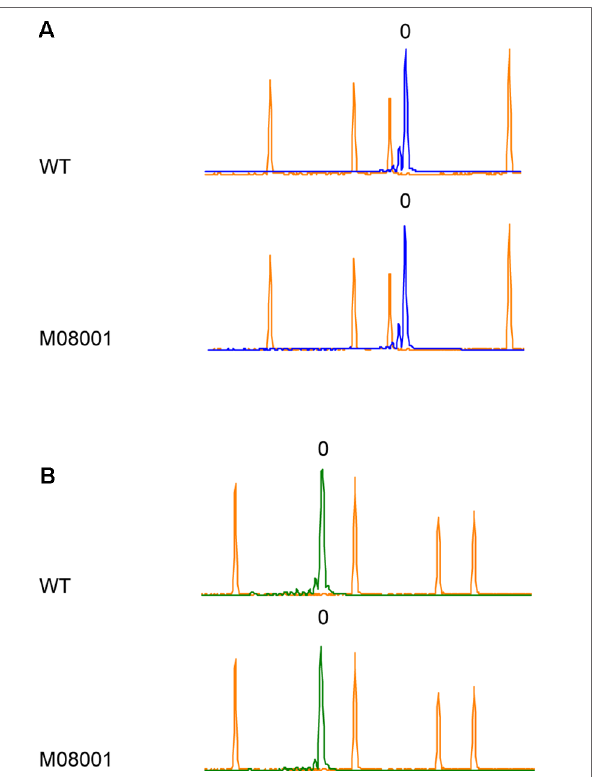
FIGURE 3 | Screening for off target mutations on StPPO1 and StPPO4 genes by HRFA. Electropherograms of wild type Desiree and line M08001 are shown. The orange peaks correspond to the elution points of the size standard and the elution of the respective wild type fragment is set to 0 (A) Blue peaks correspond to elution of the StPPO1 gene fragments (B) Green peaks correspond to elution of the StPPO4 gene